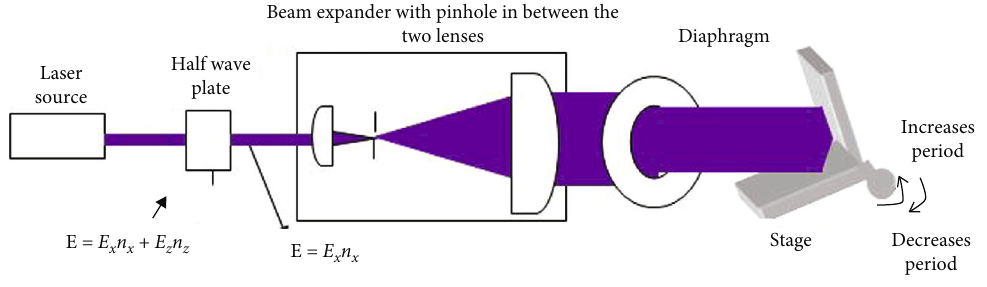
Figure 4: Setup for the interferometric